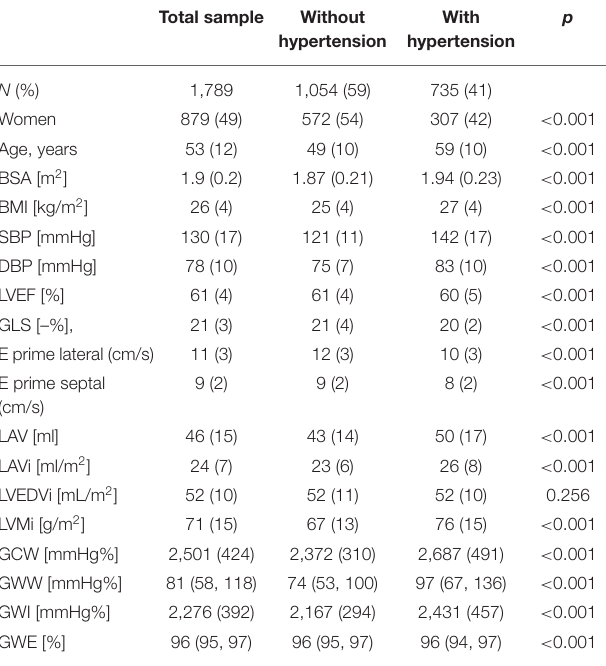
TABLE 4 | Echocardiographic patterns in participants with LV normal geometry according to the presence of hypertension. Total sample Without